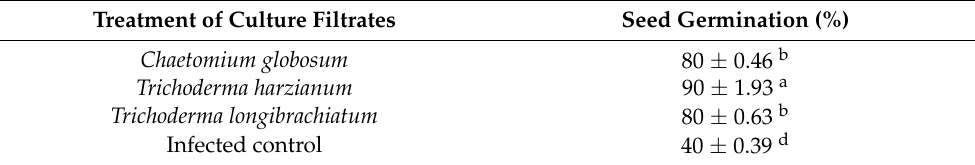
Table 2. Effect of culture filtrate of different bioagents on seed germination of cumin Baladi in vitro.